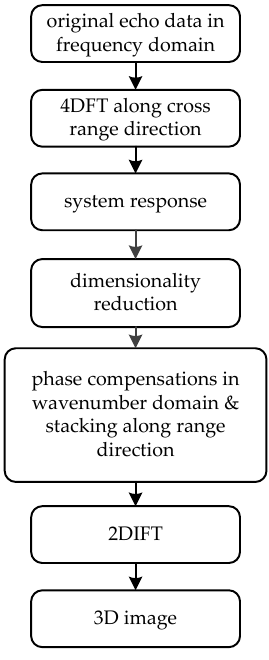
Figure 4. Block diagram of PMA for array imaging.